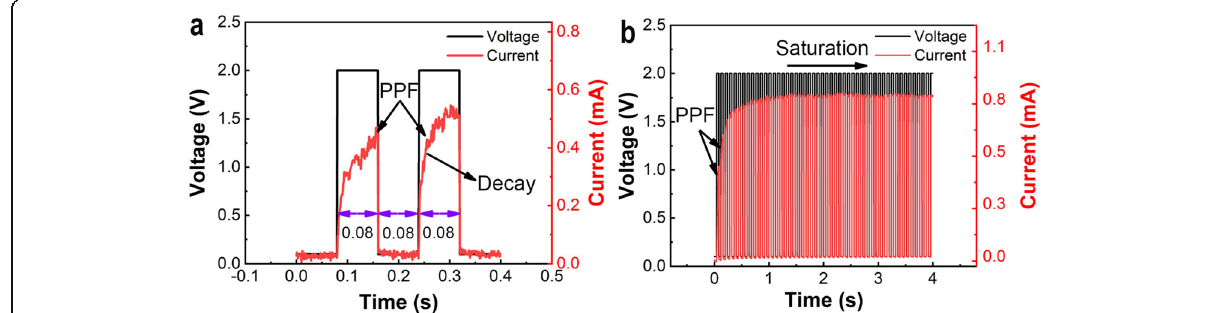
Fig. 5 Experimental results of paired-pulse facilitation (PPF) . a Implementation of PPF on Ag/SiO x :Ag/TiO x /p ++ -Si device using +2.0V pulse hight with 0.08s. b Demonstration of synaptic weight motion of saturation using pulse train of amplitude +2.0V with the same width and interval of